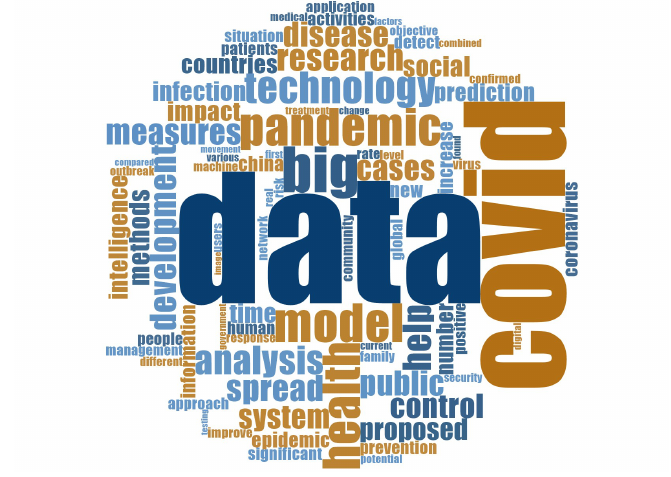
Figure 3. Word cloud of abstracts collection.